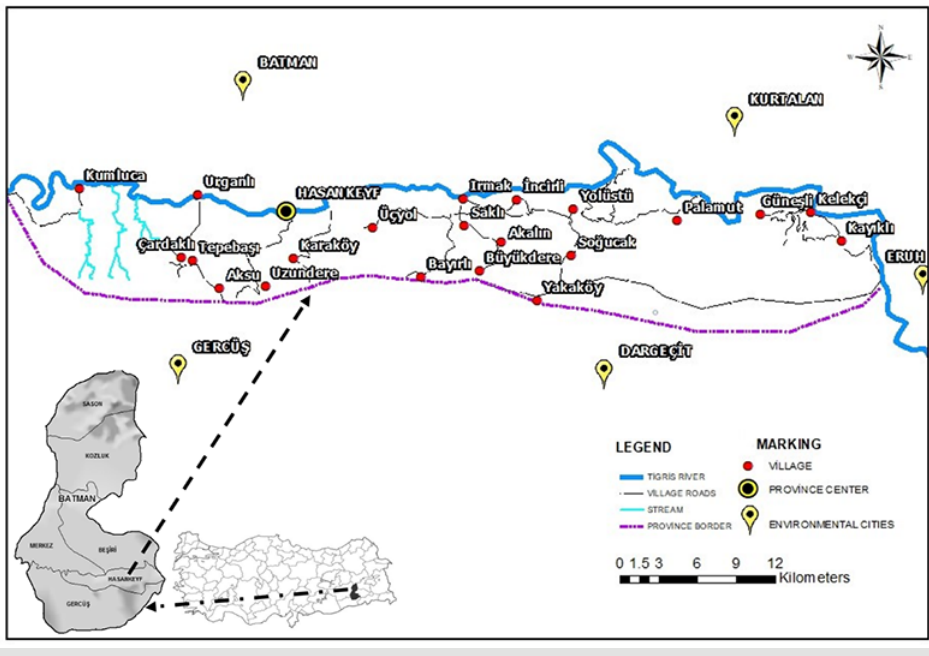
Fig. 2 Location map of the study area and its location in Batman Province and in